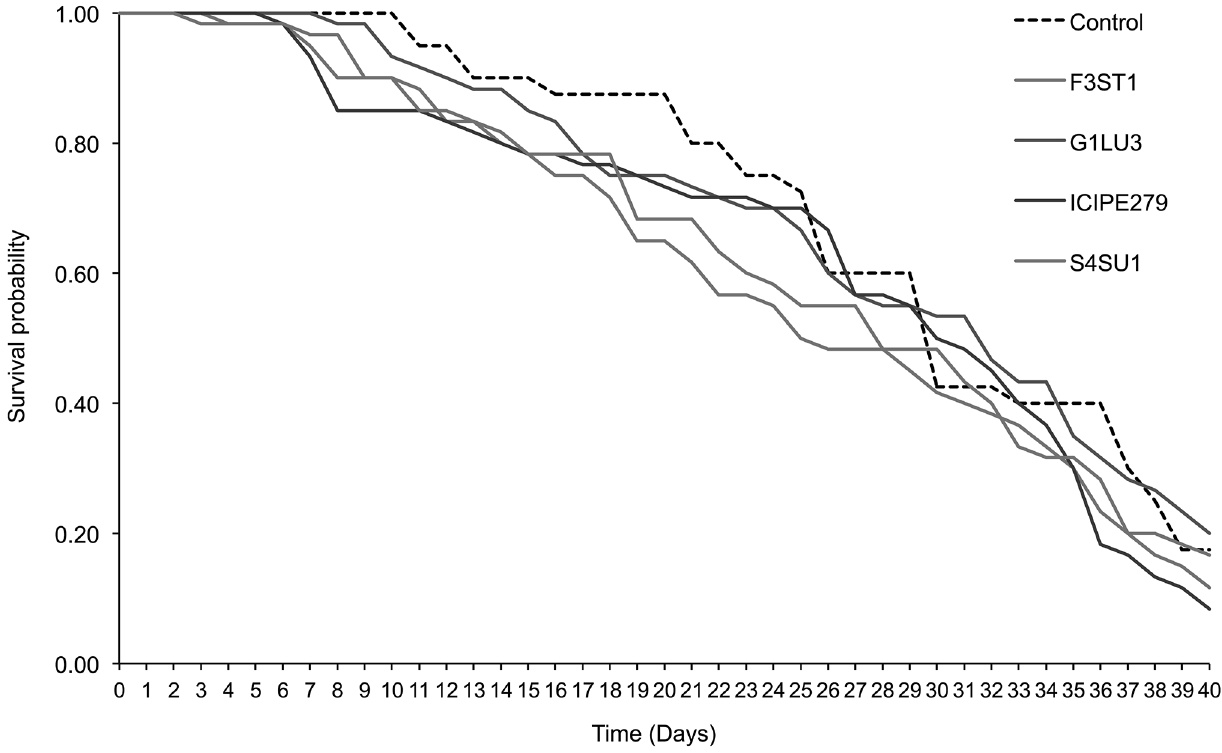
Figure 7. Progeny survival curves of Diglyphusisaea emerging from Viciafaba plants endophytically-colonized by different fungal isolates of Beauveriabassiana (S4SU1, G1LU3 and ICIPE279) and Hypocrealixii (F3ST1) and infested with 2 nd and 3 rd instar larvae of Liriomyzahuidobrensis . doi:10.1371/journal.pone.0109965.g007 PLOS ONE |